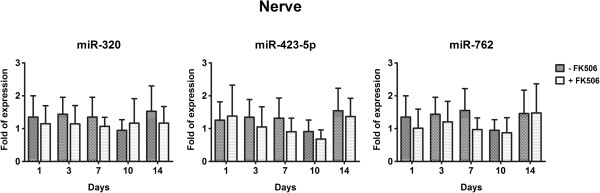
Quantification of the circulating miRNA targets in the nerve graft within 2 weeks after nerve allotransplantation by qRT-PCR. Bars represent mean ± SEM values of 6 experiments; *P < 0.05.